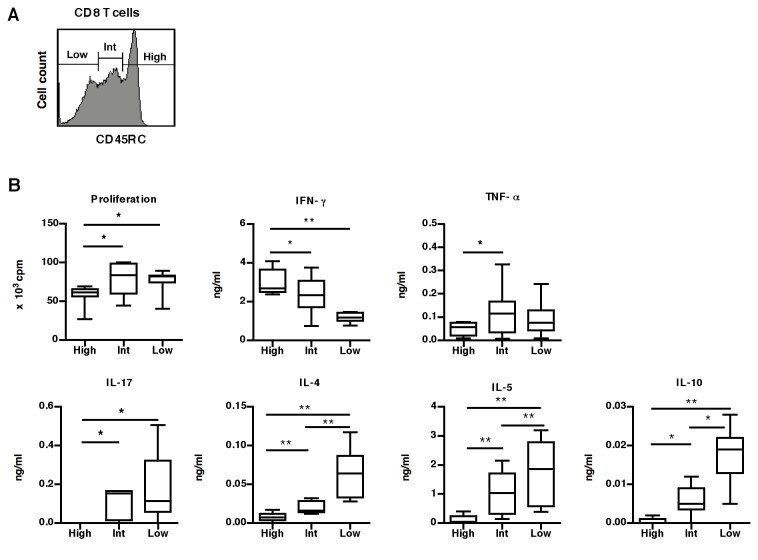
CD45RC expression identifies distinct human CD8 T cell subsets with different alloreactive properties in vitro.(A) CD45RC expression on CD8 T cells identifies three CD45RC subsets. (B) Purified CD45RChigh (High), CD45RCint (Int) and CD45RClow (Low) CD8 T cells were stimulated by MLR as described above for CD4 T cells and the proliferation and cytokine analysis were performed at day 5. The results obtained in 7 healthy individuals are presented as box-plot diagrams. Statistical results comparing the CD45RChigh, CD45RCint and CD45RClow subsets: proliferation (p{high/low}=0.043; p{high/int}=0.043), IFN-γ (p{high/low}=0.018; p{high/int}=0.043), TNF-α p{high/int} = 0.028), IL-17 (p{high/low} = 0.028; p{high/int} = 0.042), IL-4 (p{high/low} = 0.018; p{high/int} = 0.018; p{int/low} = 0.018), IL-5 (p{high/low} = 0.018; p{high/int} = 0.018; p{int/low} = 0.018) and IL-10 (p{high/low} = 0.018; p{high/int} = 0.027; p{int/low} = 0.028). The p-values were calculated using the Wilcoxon matched-pairs test; *, p<0.05; **, p<0.02; ***, p<0.002.